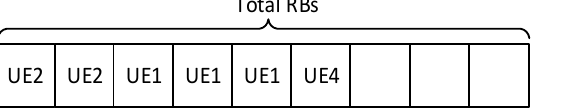
Figure 8. Allocation map ( left ); and schedule list ( right ).